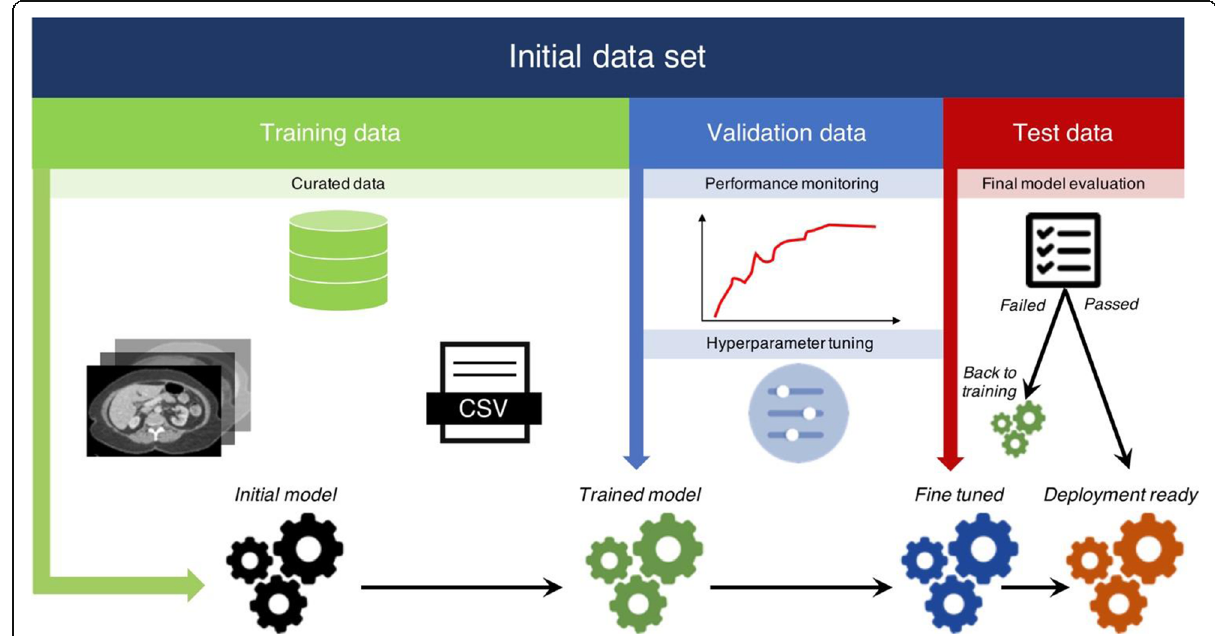
Fig. 6 Division of dataset into training, validation, and test datasets. It is recommended to perform splitting at the very beginning of the workflow, keeping test data unseen to the model until final performance